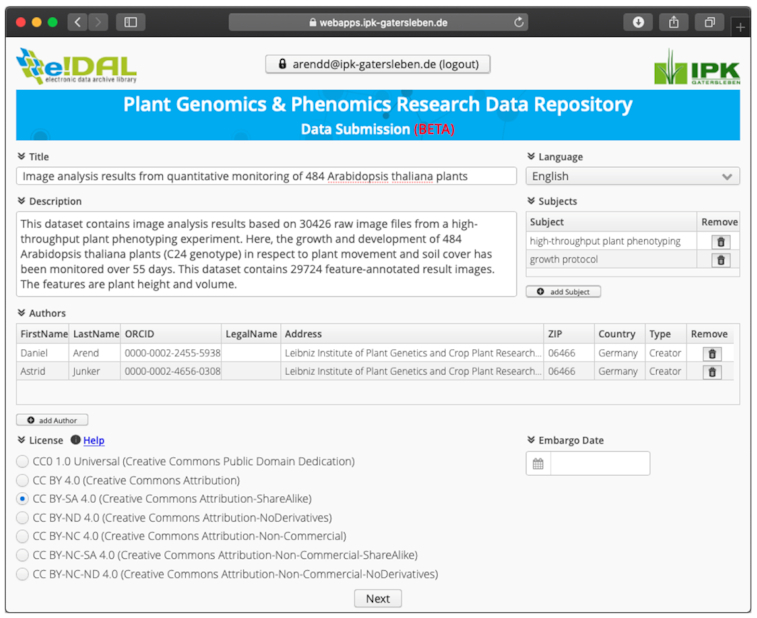
Example screenshot of the web-based submission application for the e!DAL-PGP repository. The form-like user interface is very intuitive and similar to the desktop application. It helps the user to fill in the needed metadata by executing several checks to guarantee completeness.